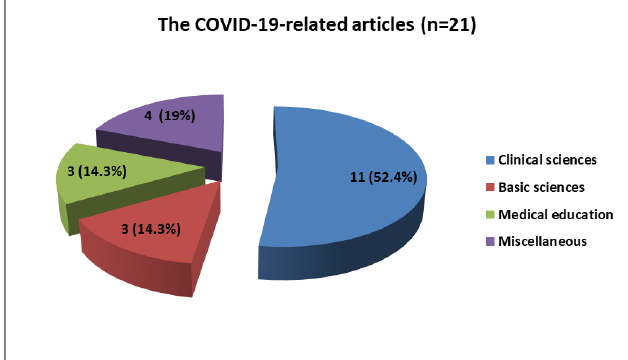
Figure 2 : The covered areas of COVID-19-related articles published in KCMJ between the years 2020 and 2022.